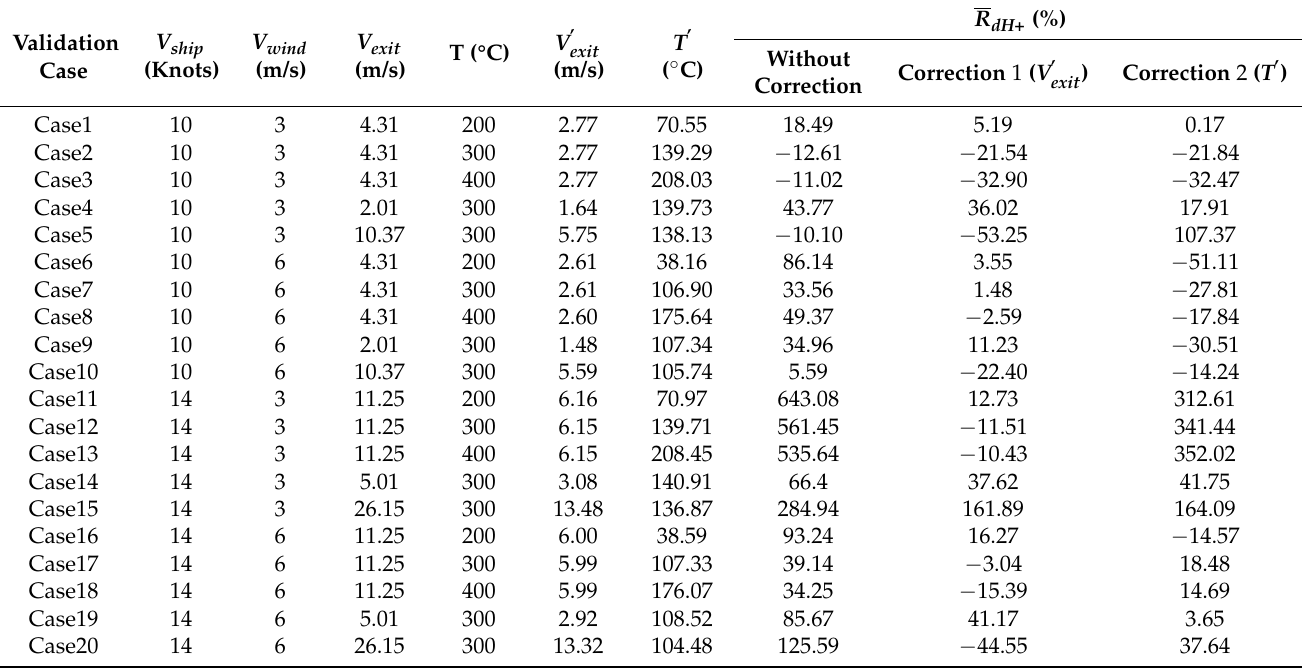
Table 4. The parameter settings and statistical differences of the verification cases in the CFD